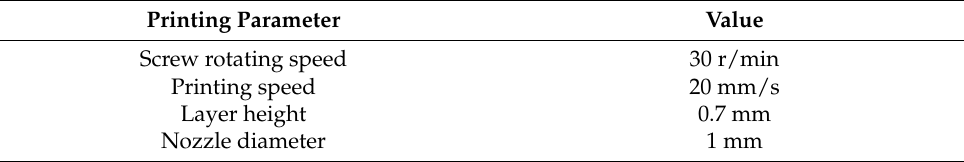
Table 1. Printing parameters of EFF.